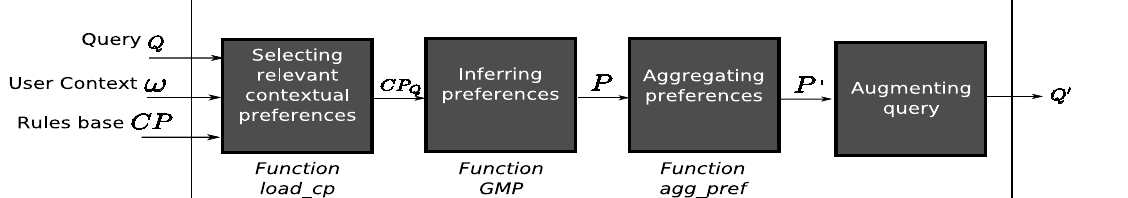
Fig. 6. Steps of augmentation query